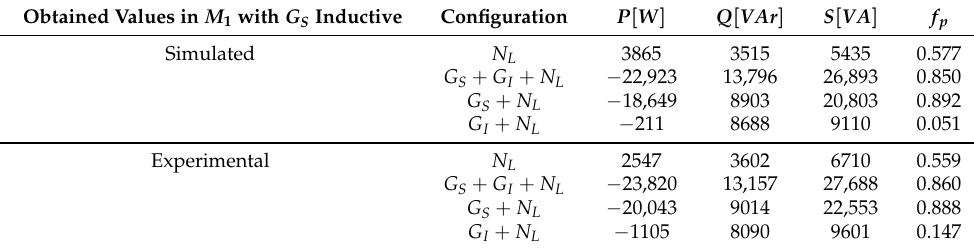
Table 8. Obtained values in M 1 with G S inductive.